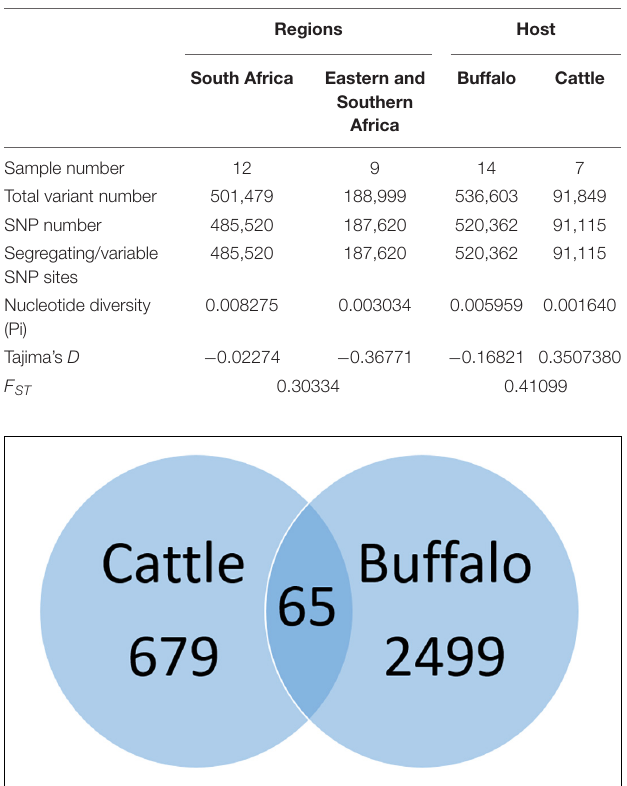
FIGURE 3 | Pairwise comparison of cattle and buffalo-derived SNPs. Sixty-five SNPs were shared between cattle and buffalo strains whereas 679 and 2499 SNPs were specific to cattle and buffalo,